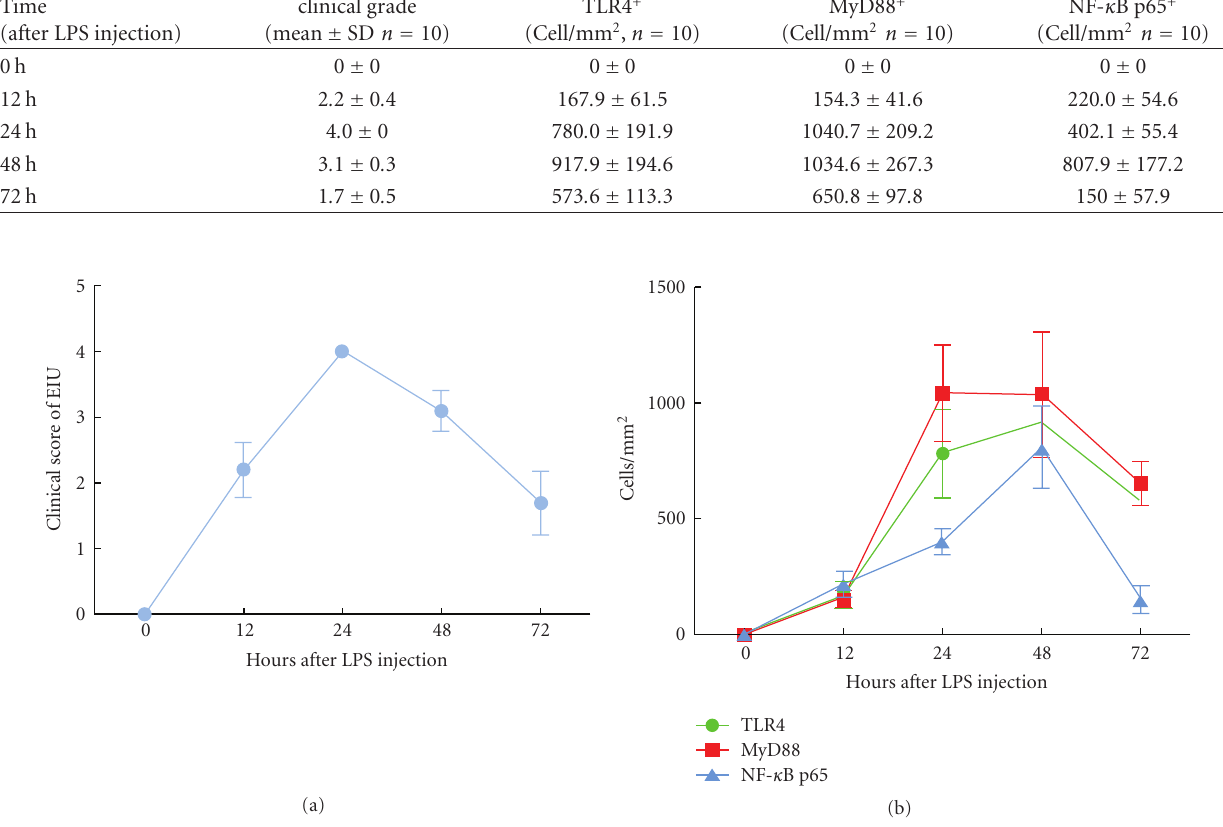
Figure 2: (a) The clinical score of EIU at di ff erent time (Data were expressed as means ± SD): the intensity of the anterior segment inflammation was evaluated at 0 ∼ 12 h inflammation reached a maximum at 24 h inflammation subsided gradually after 24 h. (b) Expression of TLR4, MyD88 and NF- κ B p65 during iris at di ff erent time (Data were expressed as means ± SD): positive cells gradually increased at 0 ∼ 24 h. Expression of MyD88 at 48 h compared with 24 h was no significant di ff erence ( P = . 940). Expression of TLR4 and NF- κ B p65 at 48h compared with 24h was significant di ff erence ( P = . 049, P = . 000). Expression of TLR4 and NF- κ B p65 declined at 72 h.